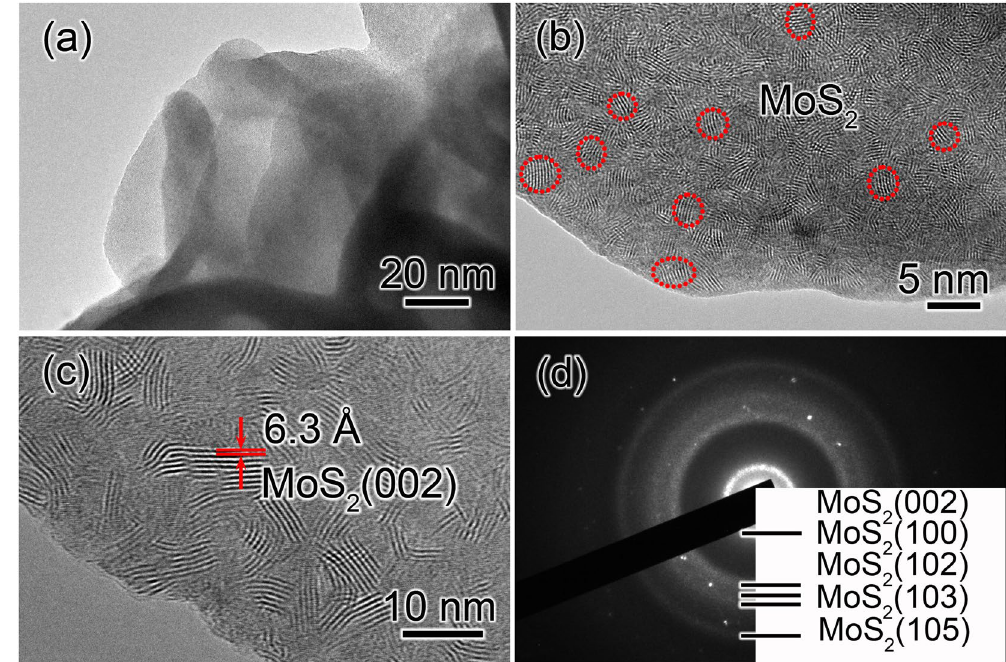
Figure 5. ( a ) TEM image of MoS 2 electrode after delithiation with a potential of + 3.0 V. ( b ) The enlarged TEM image of a delithiated